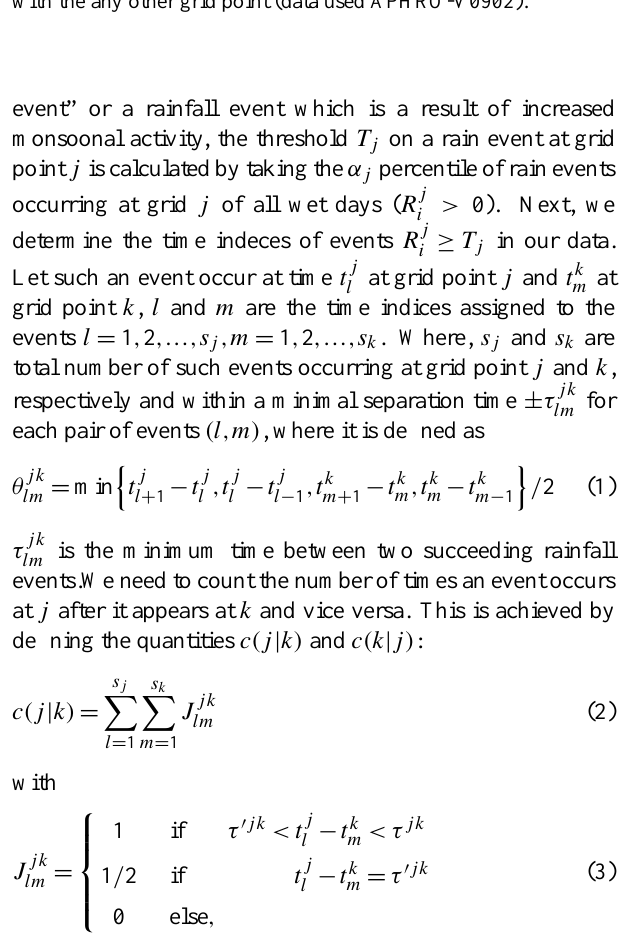
Fig. 2. Partitions of mean seasonal rainfall based on the data Fig. 2: Partitions of mean seasonal rainfall based on the data analysed from 1961 to 2004 (data used APHRO-V0902). analysed from 1961 to 2004 (data used APHRO–V0902).